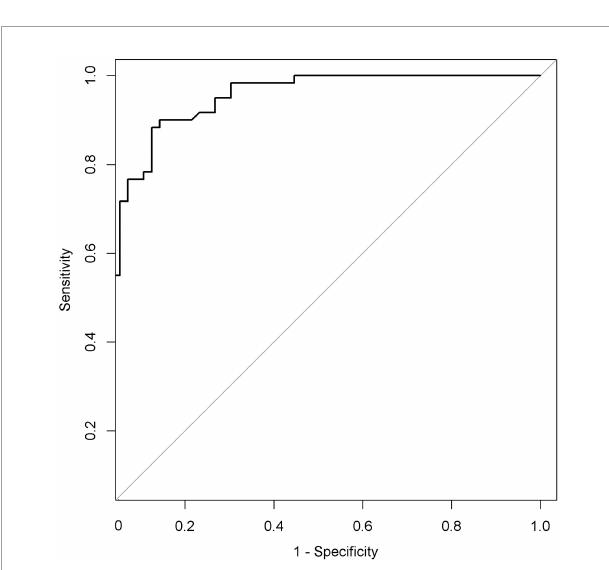
FIGURE6 Receiver operating characteristic curve (ROC) of the nomogram. The AUC of the nomogram was 0.939 (95% CI: 0.899–0.979). AUC, area under the curve.